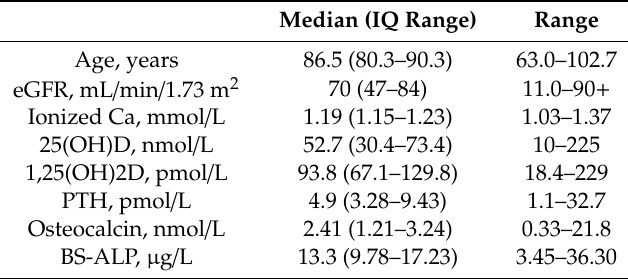
Table 1. Biochemical profile of the